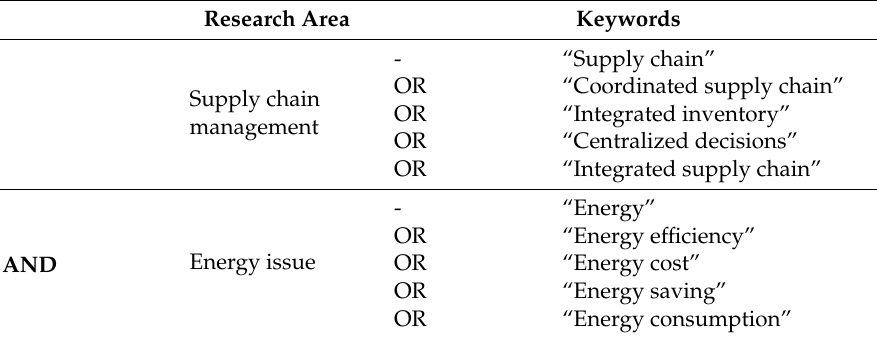
Table 1. Overview of keywords used in the literature